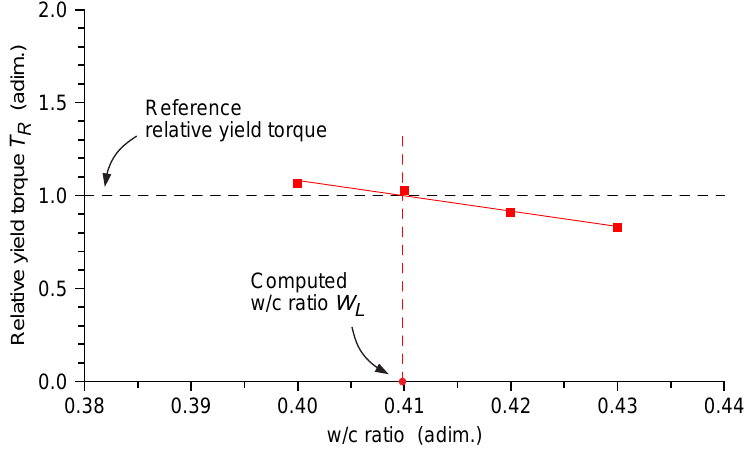
Figure 3. Bingham fitting of torque vs. rotational speed data. The Bingham dynamic yield torque T 0 was obtained by extrapolating the Bingham model to zero rotational speed.